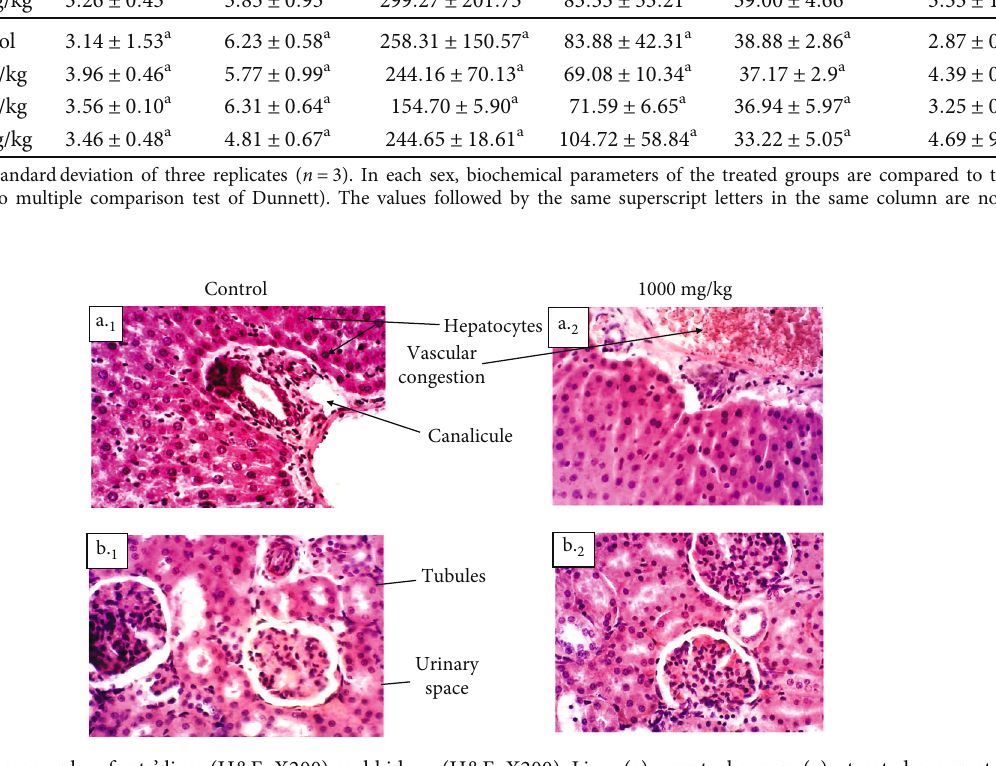
: control group; (a) : treated group at 1000 mg/ 1 2